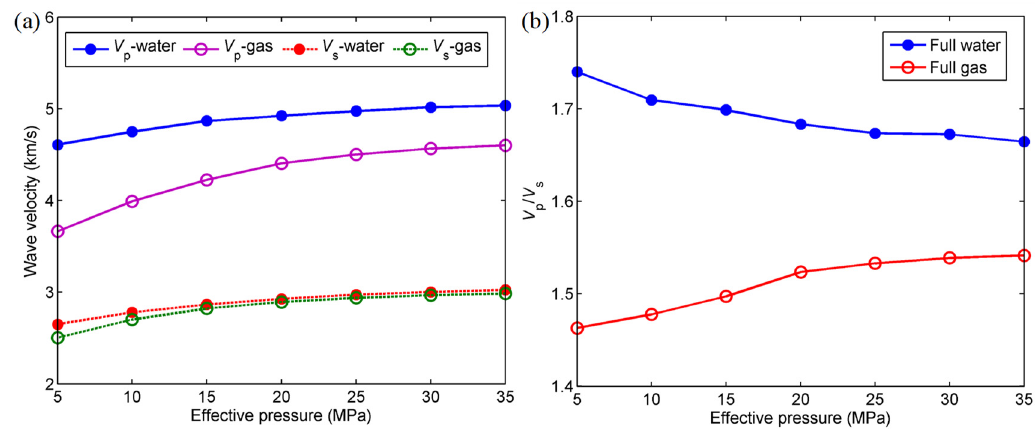
8 of 20 Figure 7. Effect of the total and microcrack porosities on the P-wave ( a ) and S-wave ( b ) velocities. 4. Ultrasonic Experiments and Sensitivity Analysis To investigate the effects of the microcracks, ultrasonic experiments at 1 MHz were performed. We select a sample with a porosity of 4.39% and a grain bulk modulus of 39 MPa. The grain, dry-rock, and wet-rock densities are 2.691, 2.573, and 2.62 g/cm 3 , respec- tively, where the sample is saturated with water. The experimental setup proposed by Guo et al. [43] is used to measure the velocities at 20 °C, with the ultrasonic pulse method. The sample is sealed with a rubber sleeve and placed in the vessel. The pore pressure and temperature are fixed. Effective pressures of 5, 10, 15, 20, 25, 30, and 35 MPa are applied